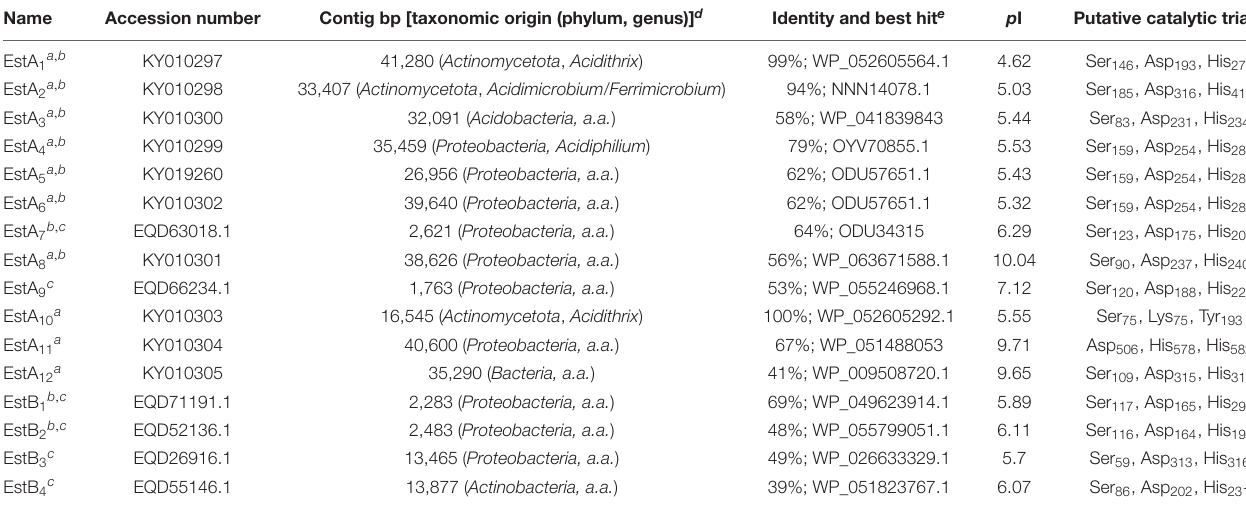
TABLE 1 | General sequence-based characteristics of Los Rueldos